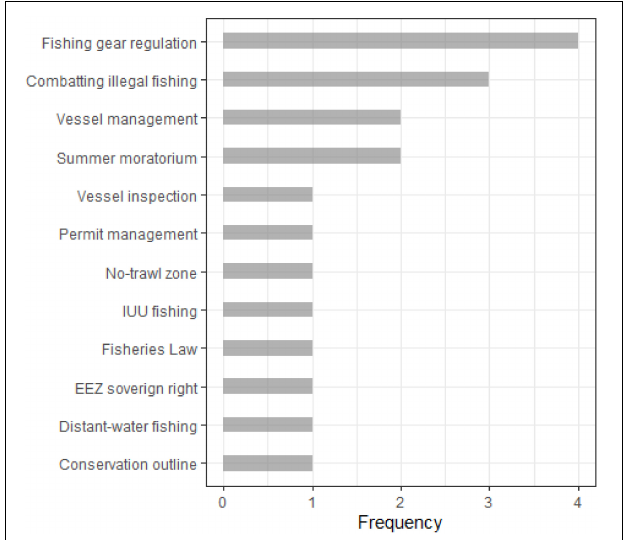
FIGURE 3 | Illustration of keyword frequency in surveyed Chinese laws and